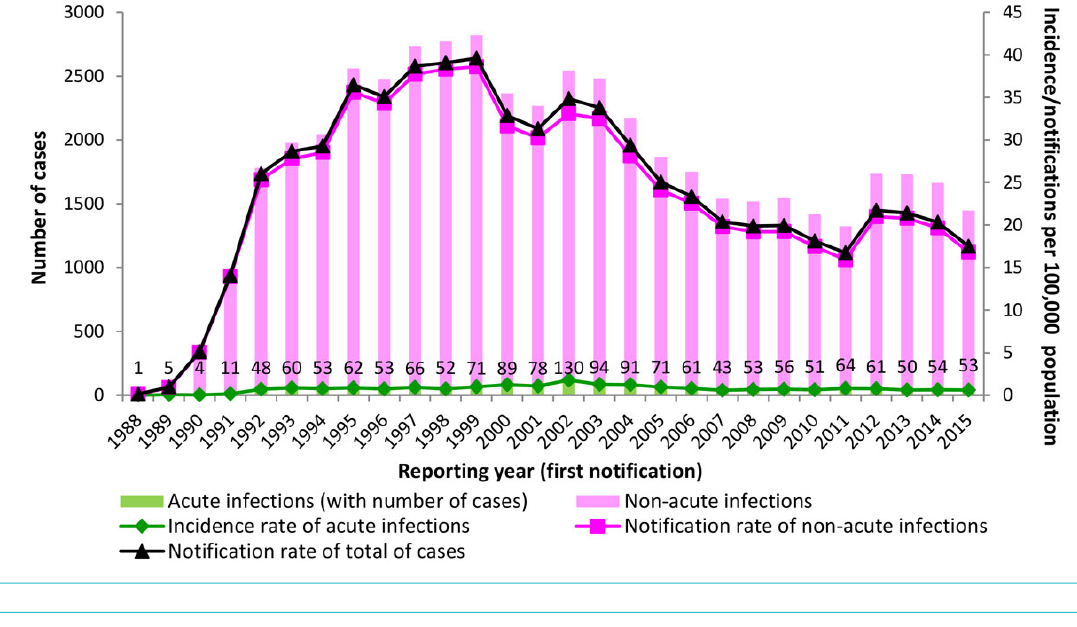
Figure 2: Notified acute hepatitis C virus cases with incidence rates by gender, Switzerland,